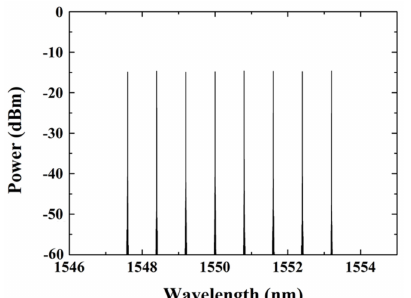
Figure 6. The spectrum of the combination of odd and even channels at output port 3 using the interleaver function.